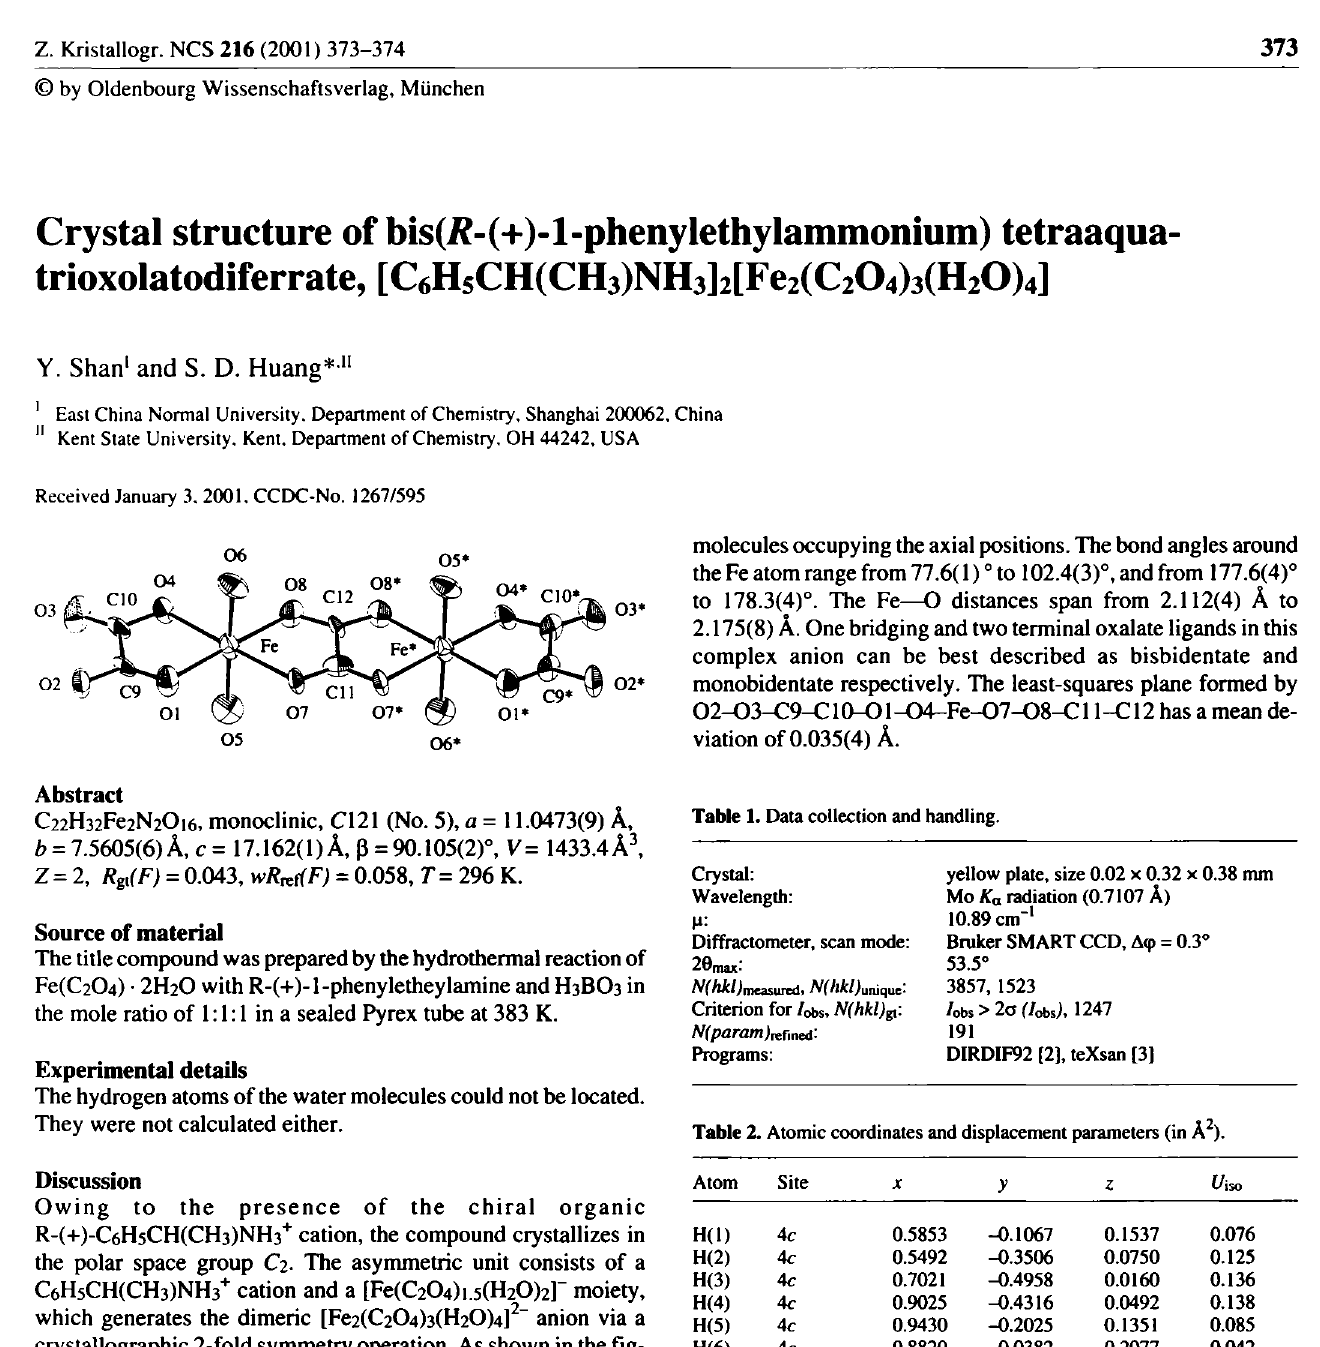
Table 2. Atomic coordinates and displacement parameters (in A 2 ).